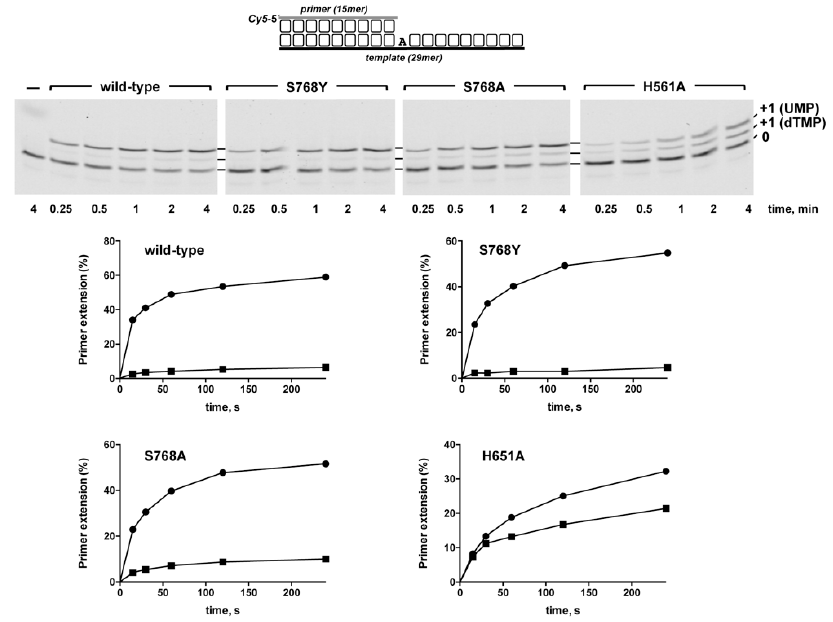
Figure 2. Sugar discrimination by Pa -PolDom wild-type and mutants S768Y, S768A, and H651A. Upper panel, primer extension assays were performed using 10 nM of the primer / template substrate depicted at top, 25 nM of either the wild-type or the specified Pa -PolDom mutant, and 100 nM of both dTTP and UTP . Samples were incubated at 30 ◦ C for the indicated times, products were resolved by denaturing PAGE and further visualized using a Typhoon 9410 scanner (GE Healthcare). Lower panel, the extent of primer extension was quantified using the ImageLab software (BioLabs), and the data plotted as a function of time. Full circles and full squares correspond to insertion of UMP and dTMP, respectively.